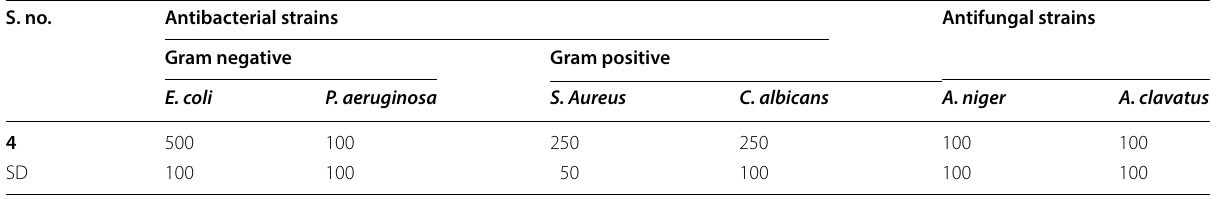
Minimum inhibitory concentrations was expressed as (µg/ml) SD Ampicillin for antibacterial drug; SD =